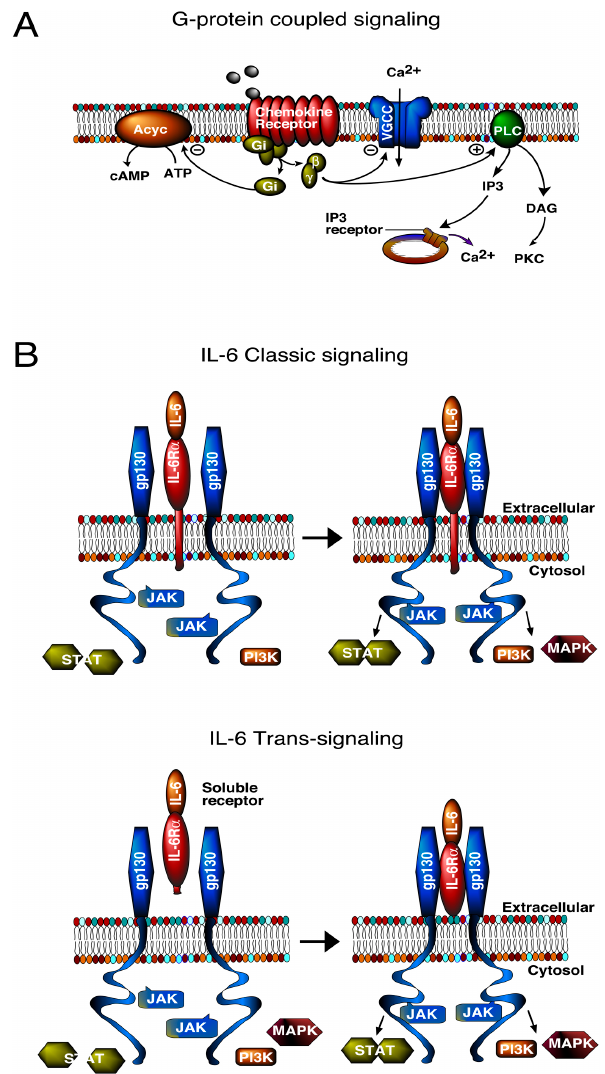
Figure 1. Diagrams showing signal transduction pathways used by chemokines and the proinflammatory cytokine IL-6. A plus sign within a circle indicates activation of the target molecule and a minus sign within a circle indicates inhibition of the target molecule. ( A ) Agonist binding to the G-protein coupled receptors (GPCR) initiates dissociation of the G-protein heterotrimer coupled to the receptor into G α and G βγ subunits. The G α and G βγ subunits then activate or inhibit downstream effectors. These effectors include ion channels, such as voltage-gated calcium channels (VGCC), and signal transduction molecules including phospholipase C (PLC) and adenylate cyclase (Acyc). Activation of PLC leads to the production of other signaling molecules including diacylglycerol (DAG) and inositol trisphosphate (IP3), and downstream activation of protein kinase C (PKC) and inositol trisphosphate receptors (IP3R), which regulate the release of calcium from intracellular stores; ( B ) IL-6 can signal through either a membrane bound (classic signaling) or a soluble (trans-signaling) IL-6R. The IL-6/IL-6R complex interacts with gp130 to activate the JAK/STAT signaling pathway. In addition, the IL-6/IL-6R/gp130 complex can activate RAS/mitogen-activated protein kinase (p44/42 MAPK, also called ERK1/2; MAPK) and phosphatidylinositol-3 kinase (PI3K) signaling pathways. All three signaling pathways activate additional downstream signaling molecules and effectors.